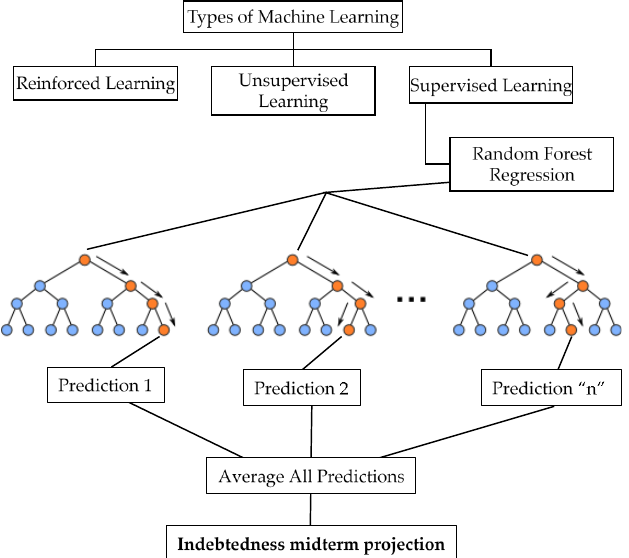
Figure 1. Structuring the Random Forest Regression. Source: upgraded author’s model based on initial findings of (TIBCO 2023).